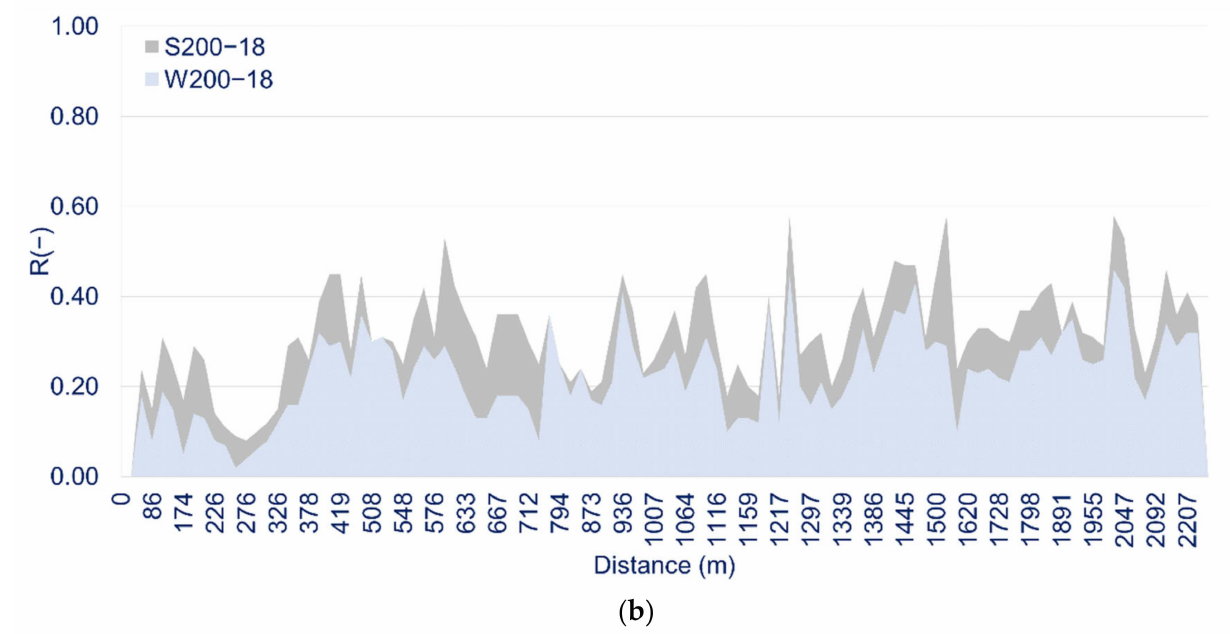
Figure 16. Calculated flood risk along Koropouli Street for 4 indicative scenarios: ( a ) Scenarios S20-06 and W20-06 for T = 20 y and t = 6 h. ( b ) Scenarios S200-18 and W200-18 for T = 200 y and t = 18